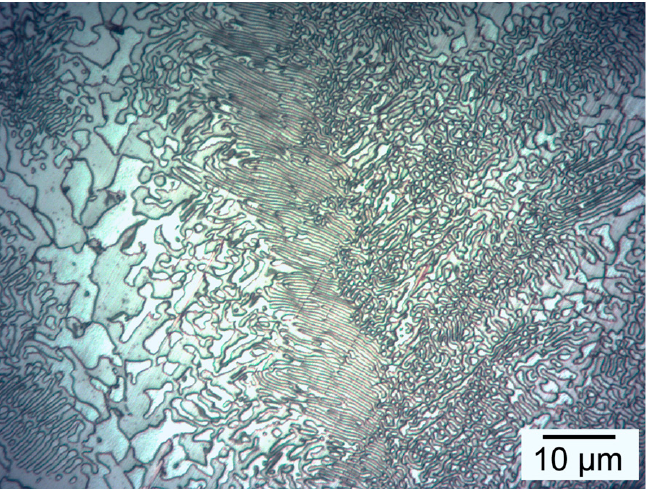
Figure 4. Optical micrograph of Al-Cu eutectic alloy directionally solidified, longitudinal section view magnified more than in Figure 1.